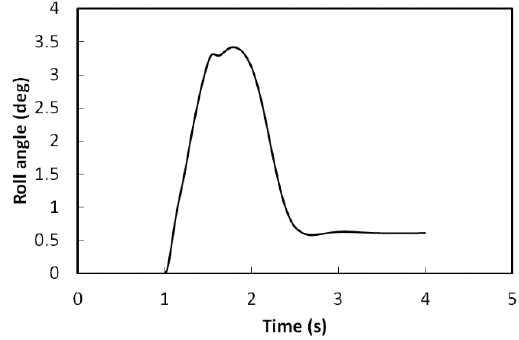
Figure 23. The roll angle with upper level control.